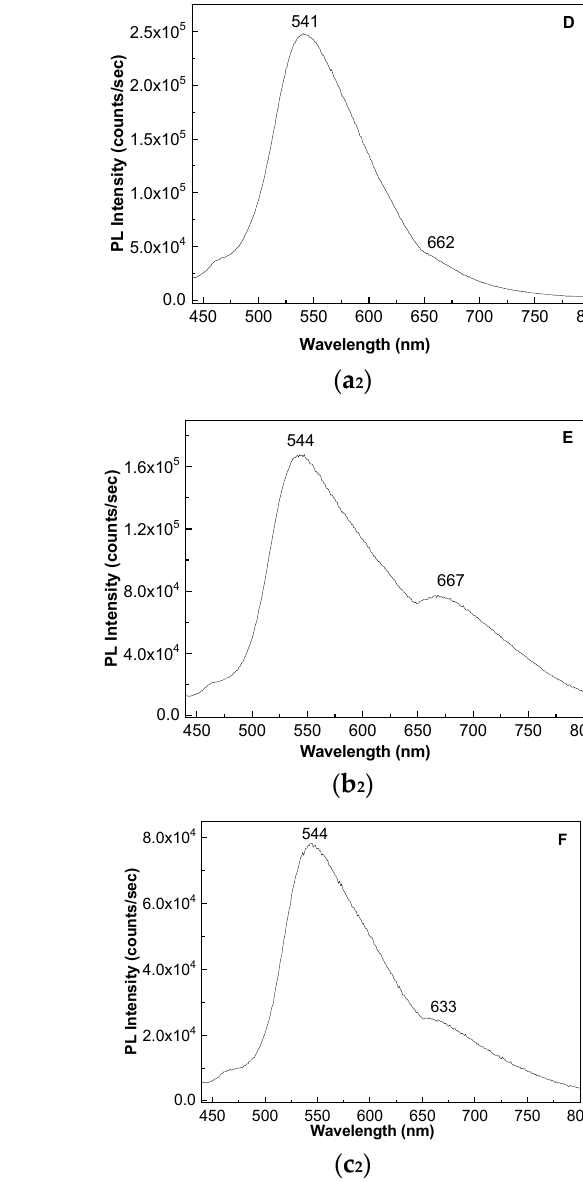
Figure 7. PLE (1) and PL (2) spectra of the composites based on the POPD-PVDF blends and DWNTs labeled D ( a 1 , a 2 ), E ( b 1 , b 2 ) and F ( c 1 , c 2 ) recorded at the emission wavelength of 600 nm and the excitation wavelength of 420 nm, respectively. In order to better understand the orientation of the macromolecular chains of POPD and PVDF in the absence and presence of DWNTs, Figures 8 and 9 show the anisotropic PL spectra of the A, B, C, D, E and F samples. Thus, Figures 8 and 9 highlight the vertical (V) and horizontal (H) polarization PL spectra when the V and H excitation beams were used. Depending on how the polarizers are mounted at excitation and emission in the spectrophotometer and the calibration factor of the instrument ( G) , the values of the anisotropy ( r ) and angle of binding of the two macromolecular compounds ( θ ) [42], can be calculated with the following